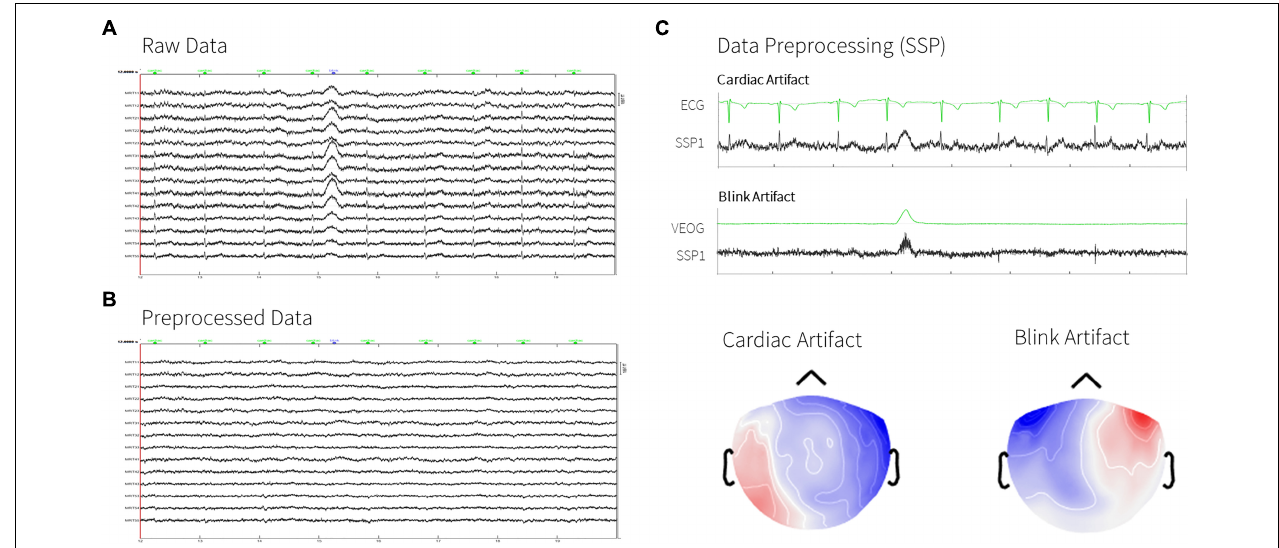
FIGURE 2 | Removal of cardiac and blink artifacts. (A) Raw data from MEG sensors (8 s, subset of right temporal sensors, sub-0004, green dots indicating the detected heartbeats). (B) Processed data after artifacts removal. (C) ECG and VEO signals and their respectives SSP signals and